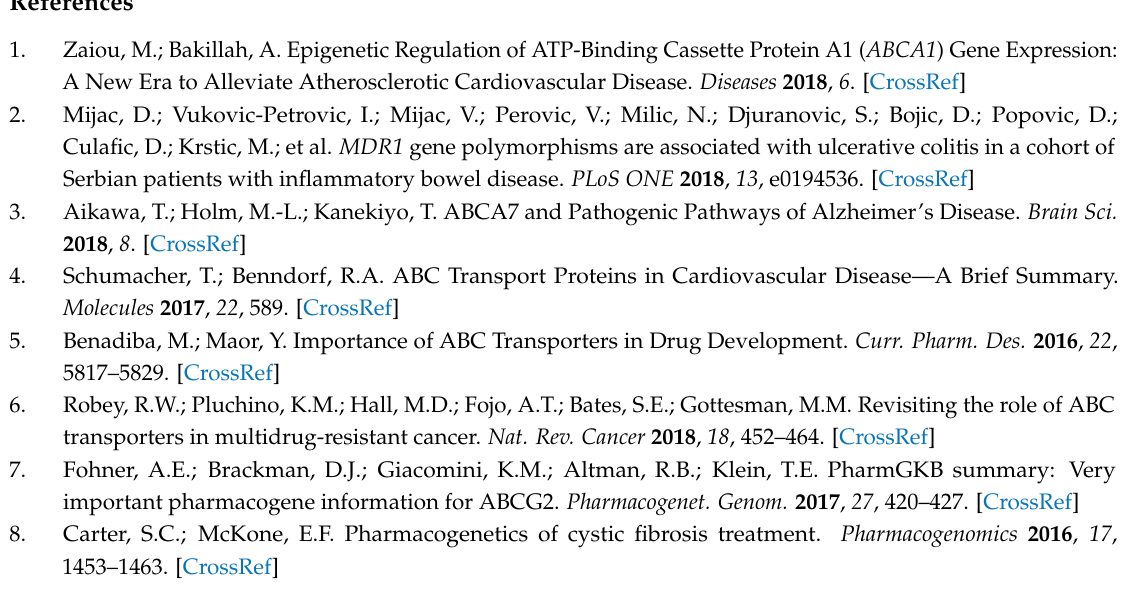
Table S1: Main variants in the ABC transporter genes with the greatest potential interest in pharmacogenetics. Funding: This study was partially supported by the Ministry of Economy and Competitiveness ISCIII-FIS grant CPII13/00008. The study was co-funded by ERDF Funds (FEDER) from the European Commission, “A way of making